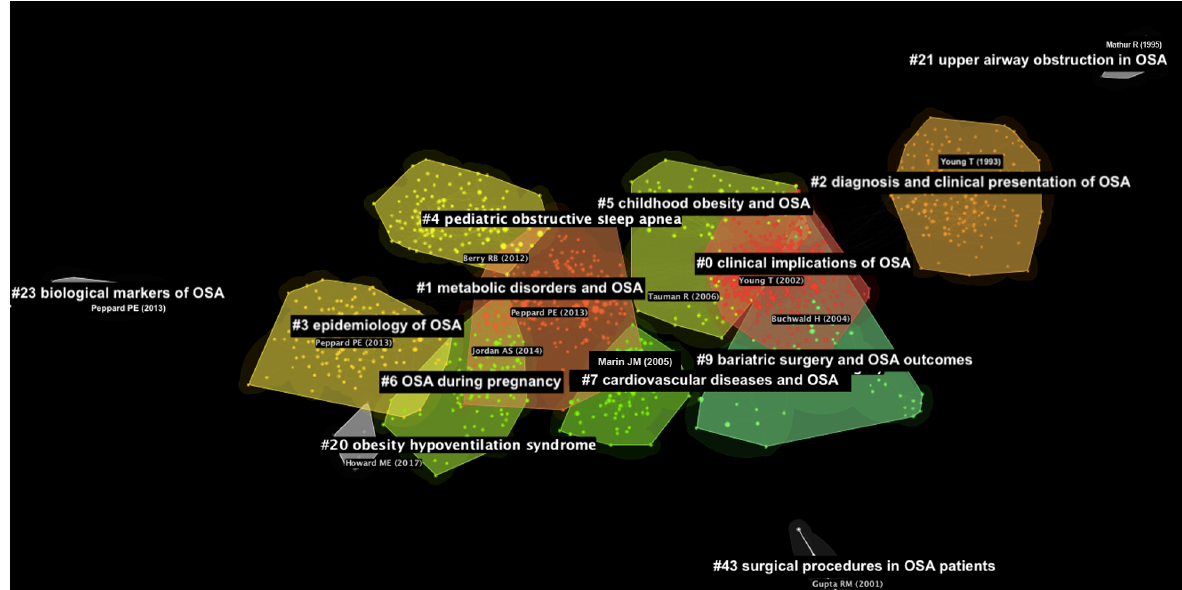
Figure 2. Network of documents generated through the document co-citation analysis (DCA). The major clusters are highlighted and divided by colour. The following articles are shown in the figure Young et al. [3], Marin et al. [17], Young et al. [25], Peppard et al. [50], Berry et al. [51], Gupta et al. [52], Buchwald et al. [53], Tauman and Gozal [54], Howard et al. [55], Jordan et al. [56], Mathur et al.